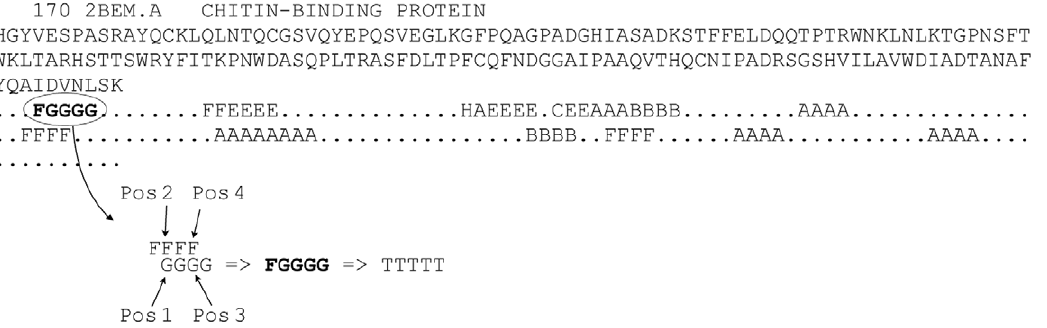
Figure 6. Assignment scheme used to train the b -turn-P method. Figure 6 is illustrating the assignment scheme used to train the b -turn-P method for an example protein sequence with PDB-identifier 2BEM.A. A b -turn with a length of five shown as T’s, is composed of two overlapping b - turn types, here indicated with F (Type VIII) and G (Type VIa2). In this situation, one b -turn residue can be assigned as being both at position 1 and at position 2. Another b -turn residue can be assigned as being both at position 3 and at position 4.